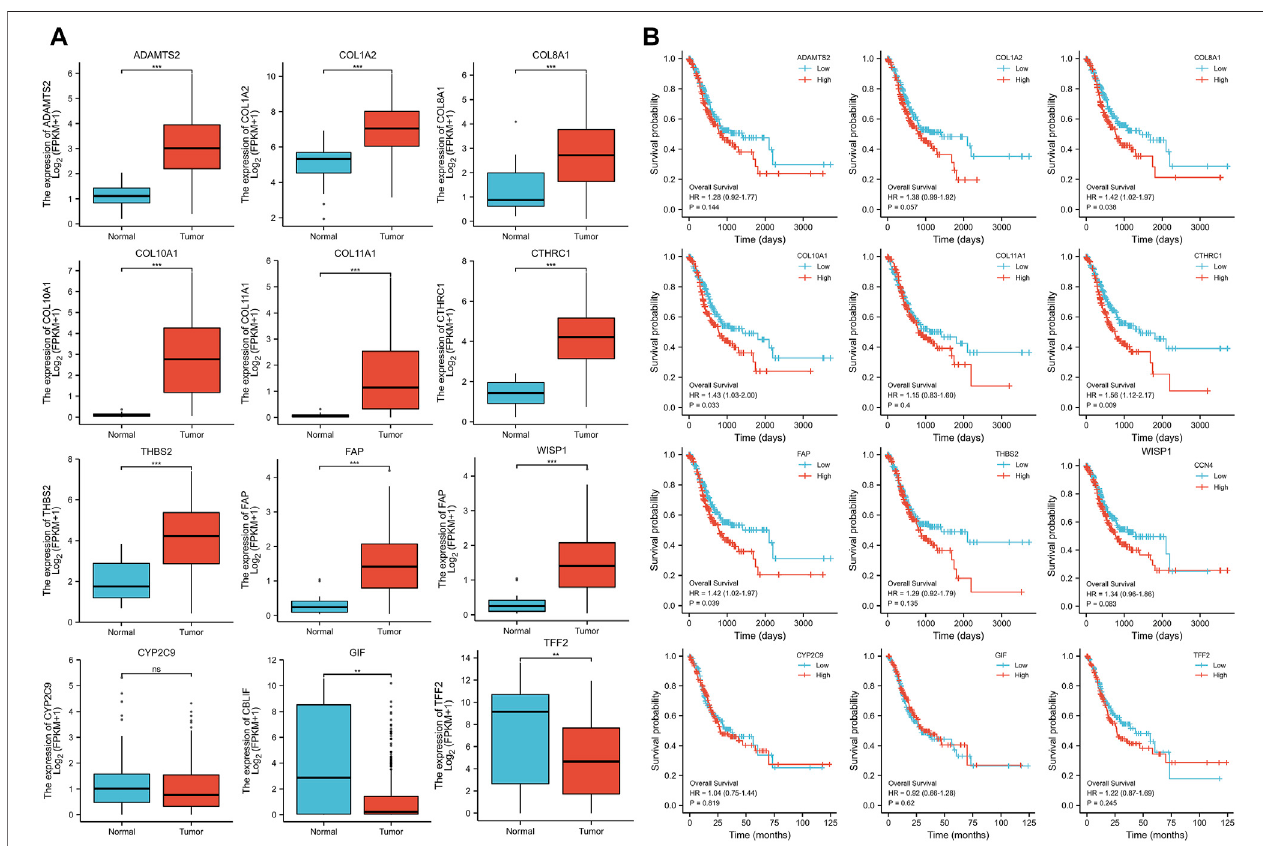
FIGURE 3 | (A) Expression levels of the hub genes between cancer samples and normal gastric tissues (B) Survival analysis of the hub genes.